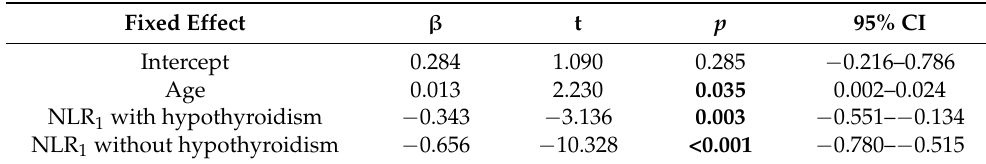
Figure 4. Final model for ∆ NLR (model F ). ( A ) Coefficients plot of the final model for ∆ NLR (model F ). NLR 1 —neutrophil to lymphocyte ratio value from the first peripheral blood count. ( B ) Visualization of model F . The horizontal axis represents the value of NLR 1 . The vertical axis represents the change in NLR from peripheral blood counts performed at the beginning of hospitalization to the pre-discharge examination. Patients diagnosed with hypothyroidism were marked on the blue scale, and patients diagnosed with hypothyroidism on the red scale. The darker the shade, the higher the age of the patient. Similarly, different colors of the lines represent predictions for patients without a diagnosis of hypothyroidism (blue scale) and with a diagnosis of hypothyroidism (red scale) and at different ages (the darker the shade, the higher the age). The 95% confidence intervals were marked in a similar manner. Table 7. Summary of the fixed effects of the model for ∆ NLR with interaction (model I